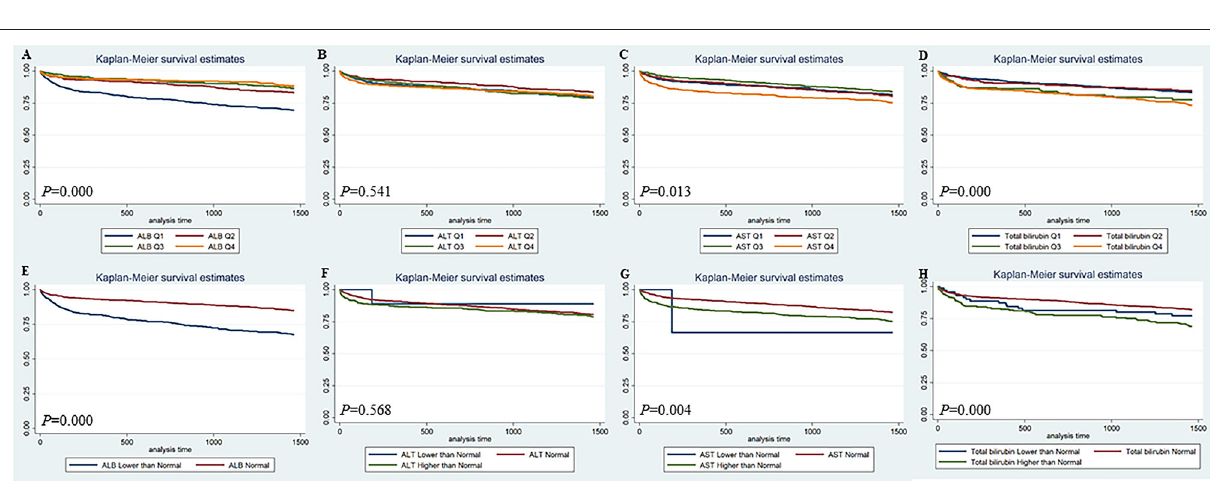
OR = 1.29, 95% CI = 1.07–1.54, p = 0.006; Model 2: OR =